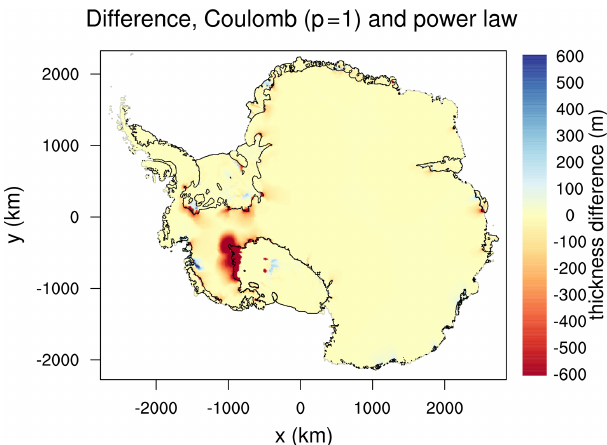
Figure 20. Difference in the ice thickness change (m) from two 550-year projection experiments, one with Coulomb basal friction ( p = 1) near the grounding line and one with power-law friction. Both runs use the nonlocal-slope-PIGL melt scheme with ocean forcing from UKESM. The ice thins in both runs. Negative values indicate greater thinning in the Coulomb run than the power-law run. Black lines show boundaries of floating ice at the end of the run with Coulomb